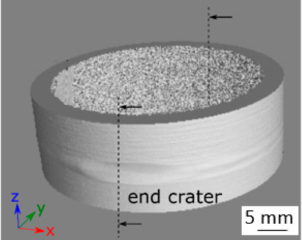
Figure 3. Circumferential weld in three-dimensional projection (3D), showing locations for the taking of cross sections.